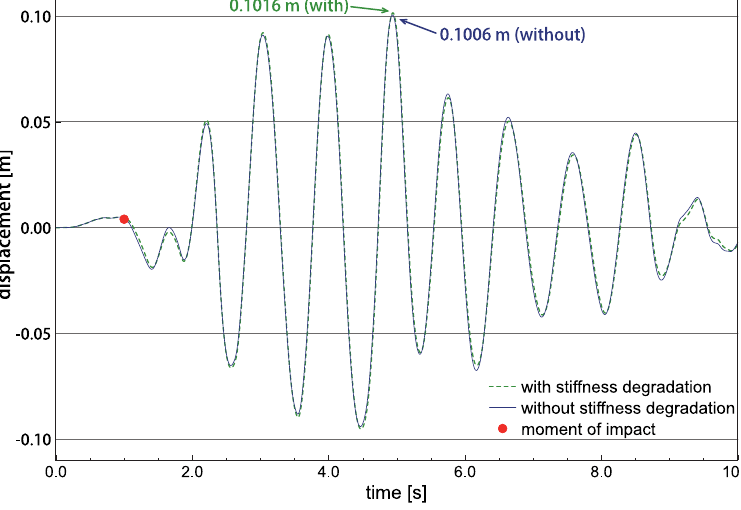
Fig. 5. Displacement time history of the first story of building under the El Centro earthquake with and without considering the degradation of horizontal stiffness for impact at t = 1 s.